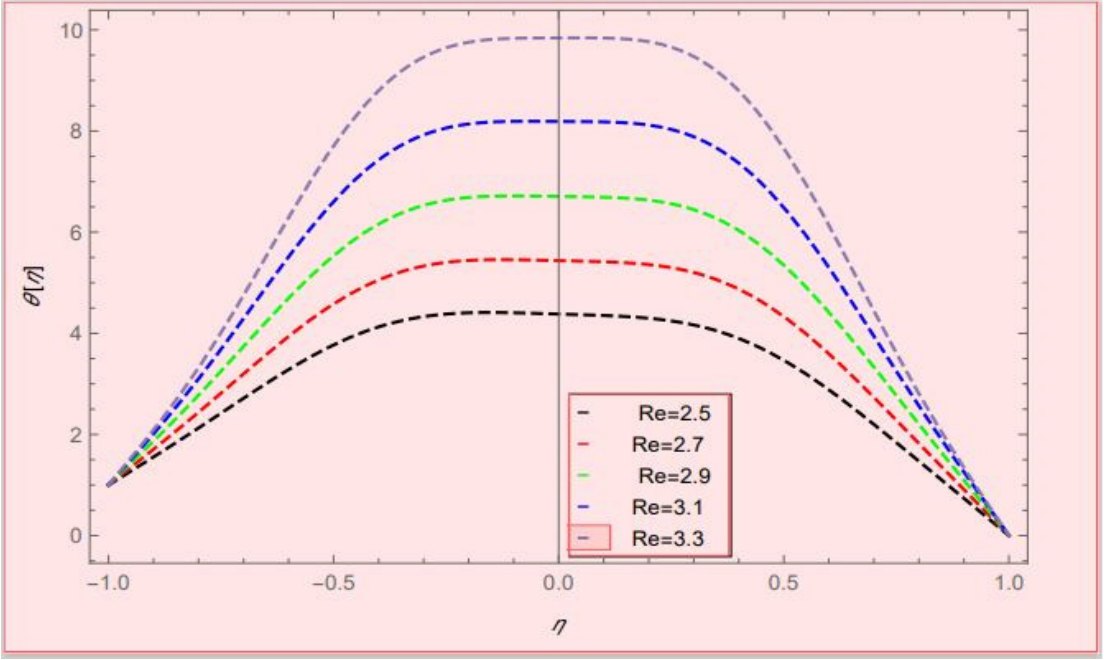
Figure 9. Temperature profile effect against the Reynolds number for 𝛼 = 4, 𝑃𝑟 = 0.1, 𝑁𝑡 = 0.7, 𝑁𝑏 = 0.7, 𝑀 = 9, 𝛽 = 1.3, 𝐵𝑟 = 0.03,𝜑 (cid:2869) = 𝜑 (cid:2870) = 0.02,ℎ = 2,𝑟 = 1.5 .